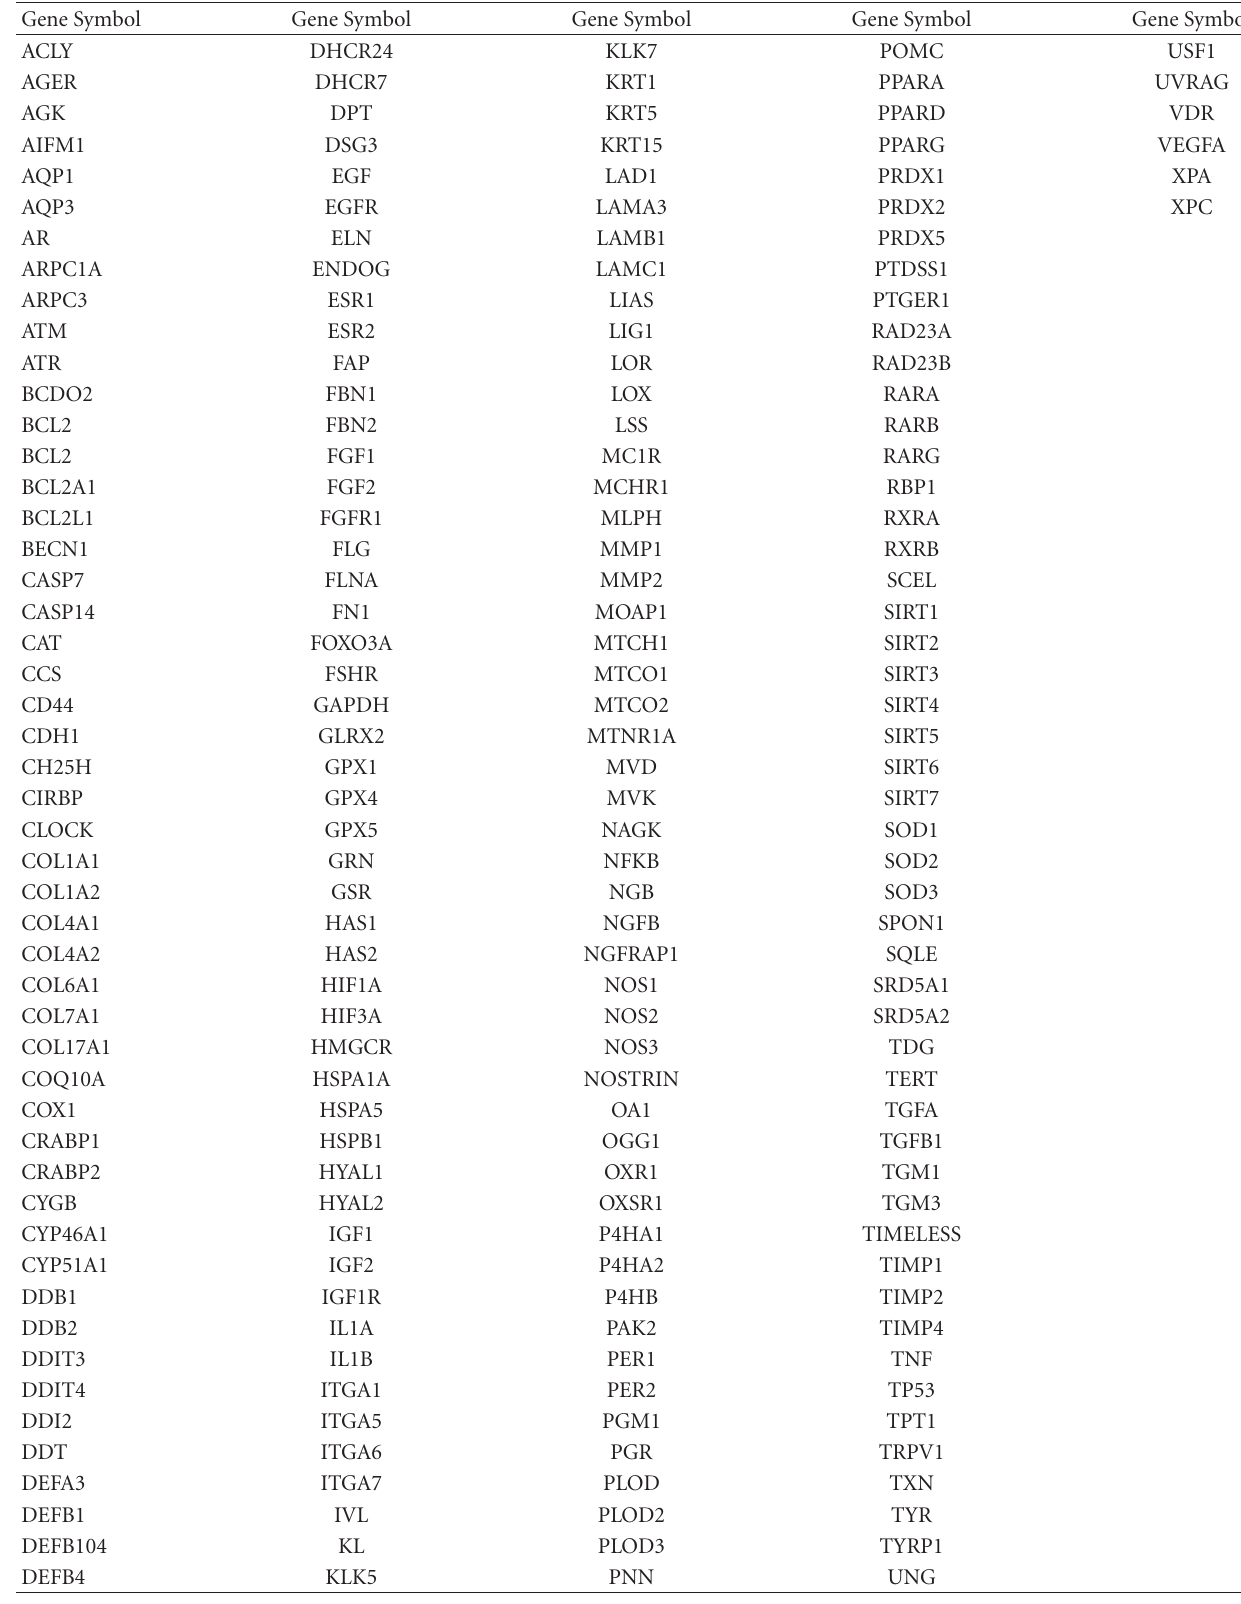
Table 2: Summary of Genes